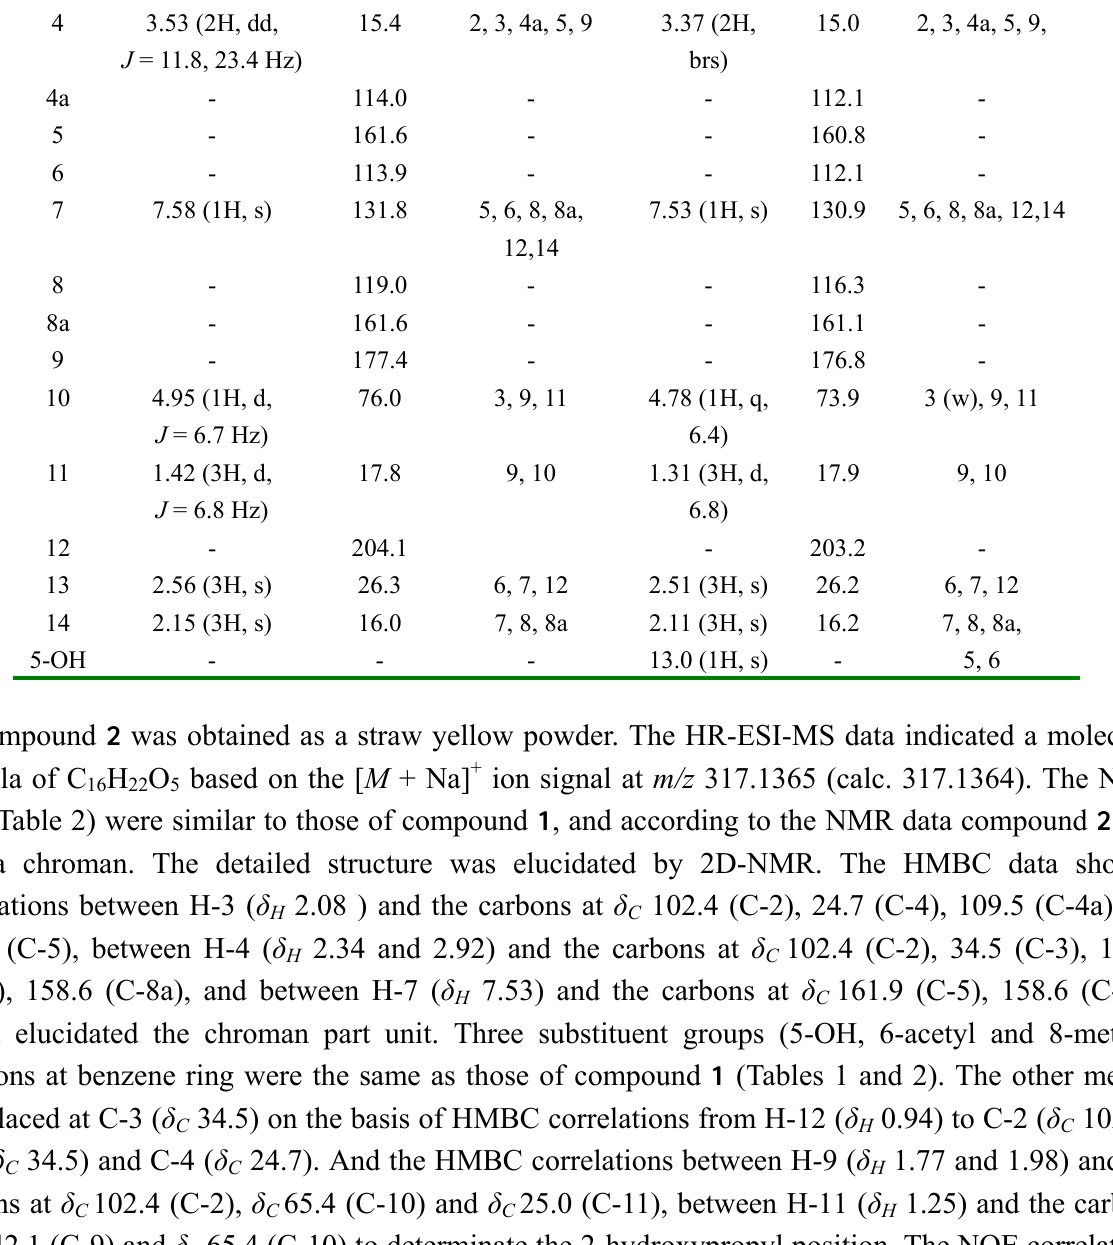
Table 1. NMR data of compound 1 (in CD